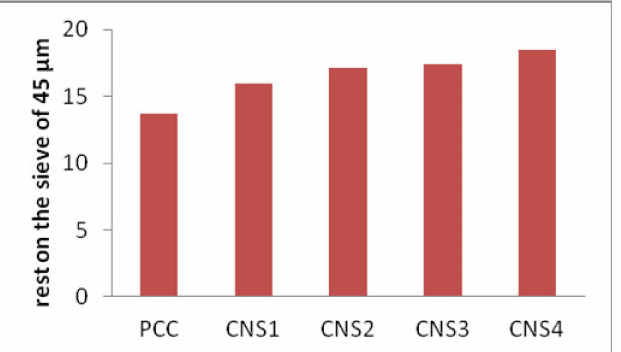
Figure 7. The effect of Napa soil usage on the percentage remaining on 45 µ m sieve.